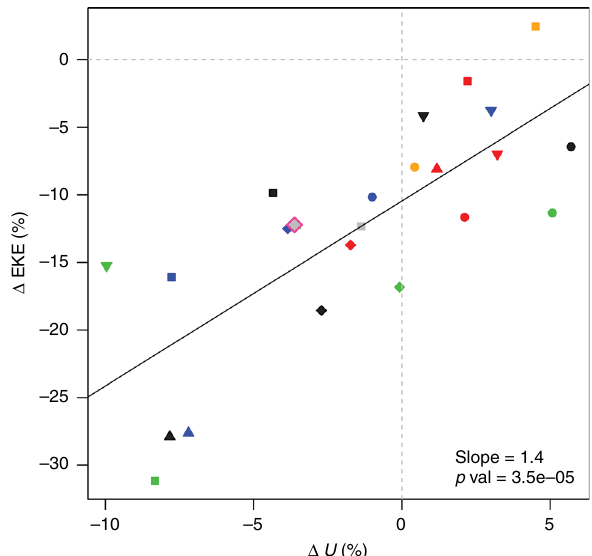
Fig. 4 Observed and projected changes in the mid-latitude Northern Hemisphere summer storm tracks and westerlies. The percentage change in summer storm tracks (vertical axis) and westerlies (horizontal axis) in future (2081 – 2100, under scenario RCP8.5) relative to 1981 – 2000 for individual CMIP5 climate models is shown, and their linear fi t (solid black line). Observed changes based on ERA-Interim data are given for the 1979 – 2013 period. Taken from (Coumou et al. 26